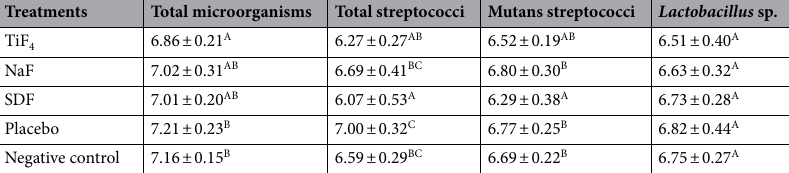
Table 2. Mean and standard deviation of the colony forming unit (CFU) counting (log 10 CFU/mL) for total microorganisms, total streptococci, mutans streptococci and Lactobacillus sp . Different letters in the same column indicate significant differences among the treatments. ANOVA and Tukey–Kramer test (total microorganisms p = 0.003; total streptococci p < 0.0001; mutans streptococci p = 0.0001 and; Lactobacillus sp . p = 0.23).